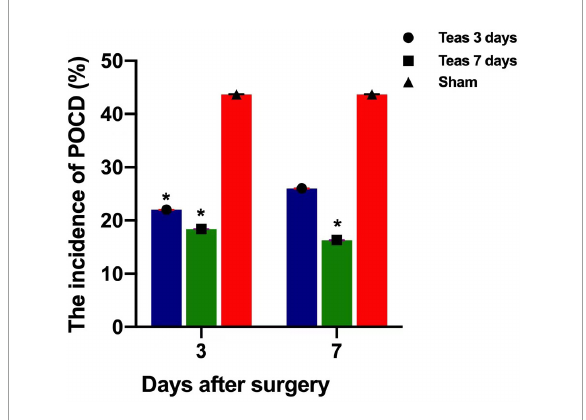
FIGURE3 Postoperative incidence of POCD in three groups (%). ∗ P < 0.05 vs. group C; ∗ P < 0.05 vs. group